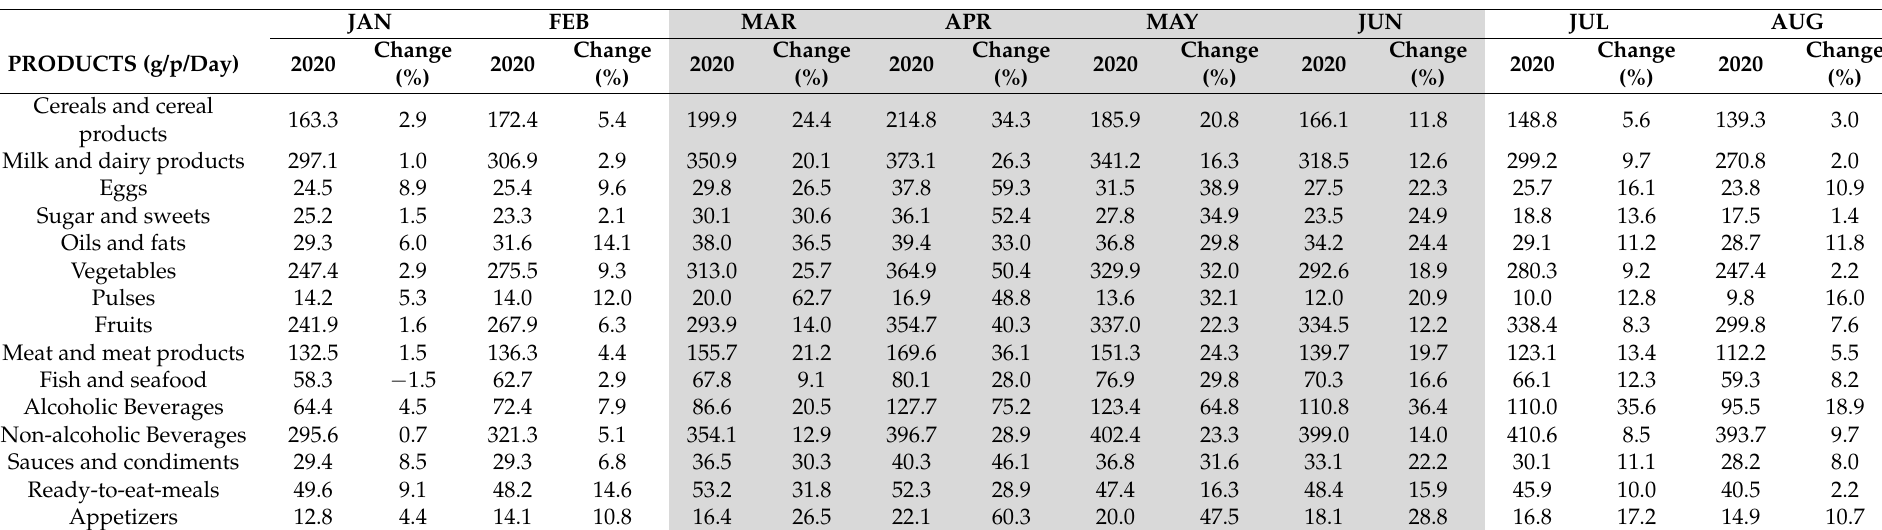
Table 1. Food and beverage purchases in Spanish households in 2020 (grams/person/day), and relative change with respect to 2019 (%). JAN